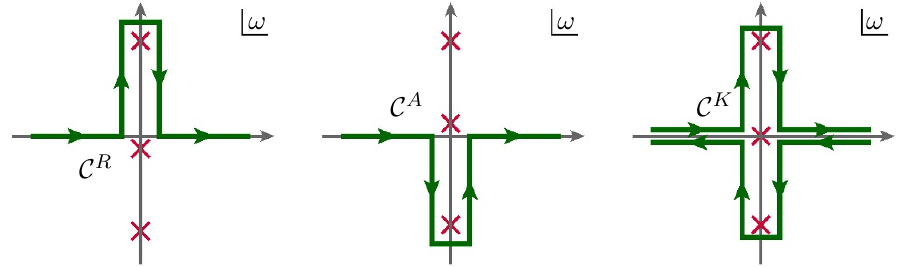
Figure 1 . Contours in the complex ! -plane, de(cid:12)ning the retarded, advanced, and Keldysh (sym- metric) correlation functions, respectively. The contour C K = C R (cid:0) C A . The red crosses denote the poles of the integrand at ! 2 f(cid:0) i; 0 (cid:6) i"; i g , where " > 0 is a small regulator that enforces consistent boundary